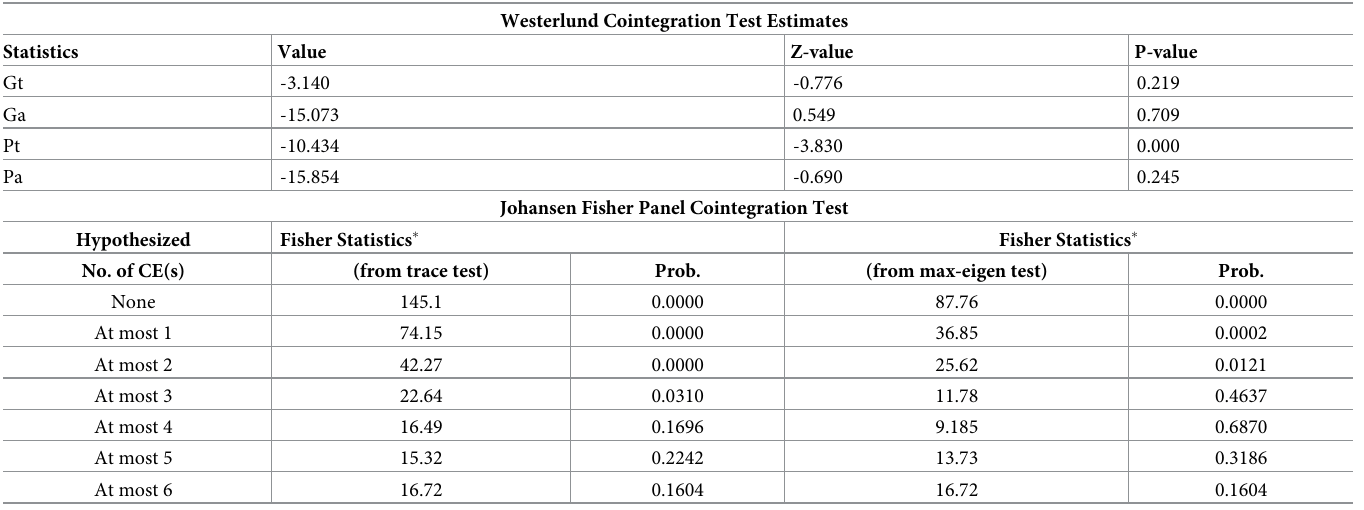
Table 7. Westerlund and Johansen Fisher panel cointegration test estimates.